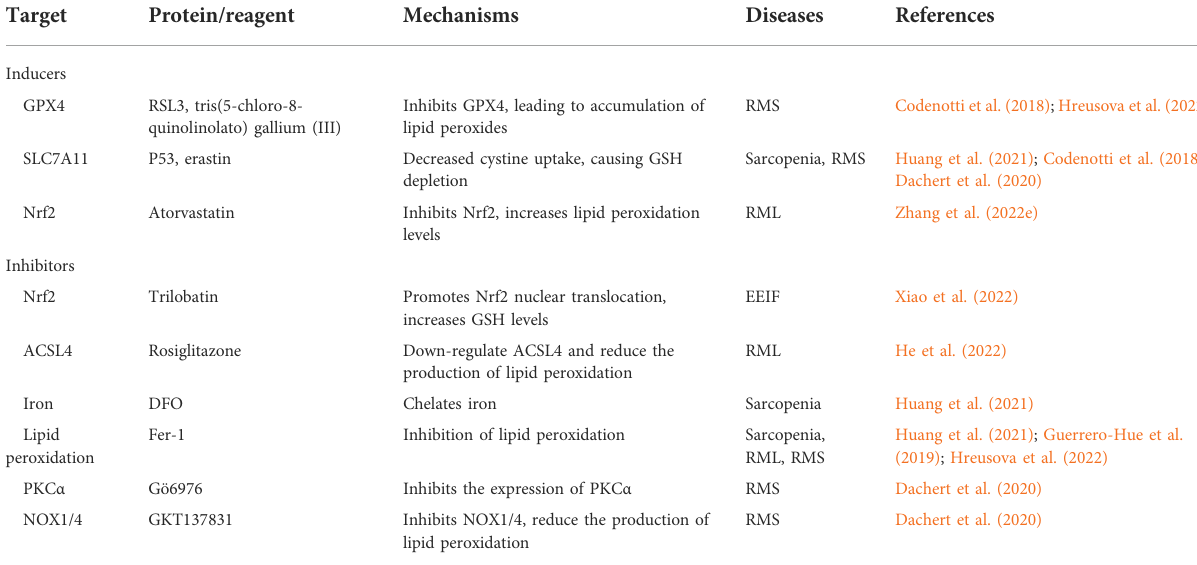
TABLE 2 Therapeutic strategies for skeletal muscle diseases associated with